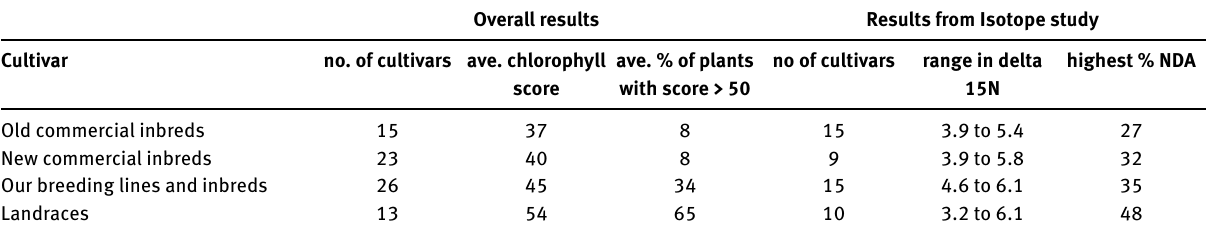
Table 3: Data for chlorophyll scores for leaves and N isotope distribution in grain for maize grown in 2009 on an N limited site near Elkhorn, Wisconsi